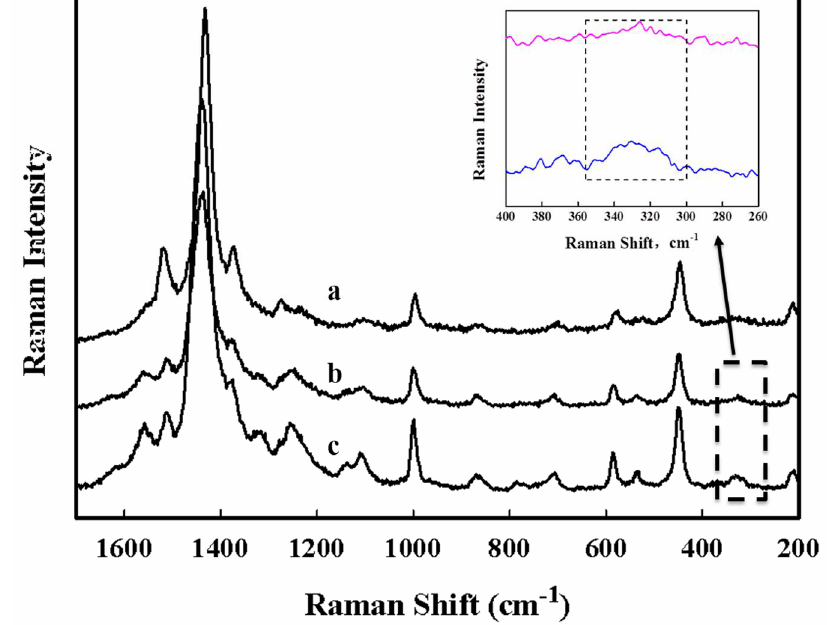
Figure 5. Raman spectra for electrodes, (a) PEDOT/Pt, (b) PEDOT:BSA/Pt, and (c) AuNPs/PEDOT:BSA/Pt. The inset indicates the expanded spectra between 260 and 400 cm −1 for curves (b) and (c).